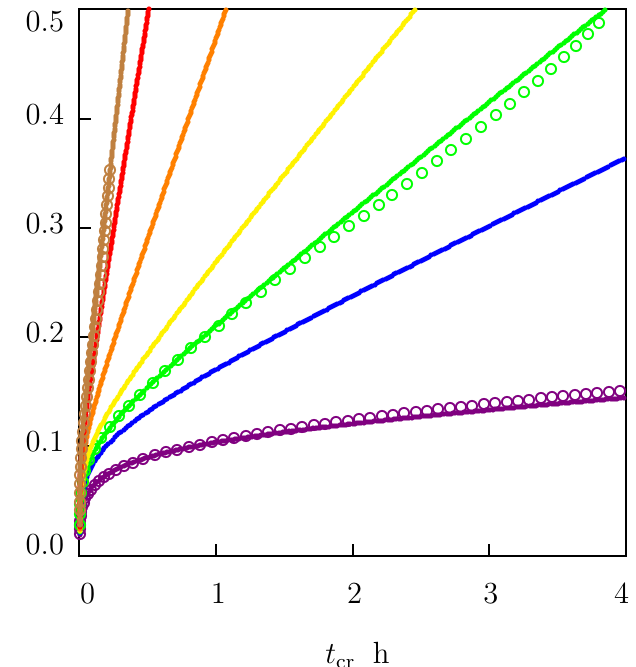
Figure 6. Tensile strain (cid:101) versus creep time t cr . Circles: experimental data in creep tests with stresses Figure 6: Tensile strain (cid:15) versus creep time t . Circles: experimental data in creep tests σ = 15.0 (violet), σ = 17.5 (green) and σ = 20.5 (brown) MPa. Solid lines: predictions of the model for cr creep tests with various stresses σ : violet—15.0, blue—17.0, green—17.5, yellow—18.0, orange—19.0, with stresses σ = 15 . 0 (violet), σ = 17 . 5 (green) and σ = 20 . 5 (brown) MPa. Solid lines: red—20.0, brown—20.5 predictions of the model for creep tests with various stresses σ : violet – 15.0, blue – 17.0, green – 17.5, yellow – 18.0, orange – 19.0, red – 20.0, brown – 20.5 MPa.